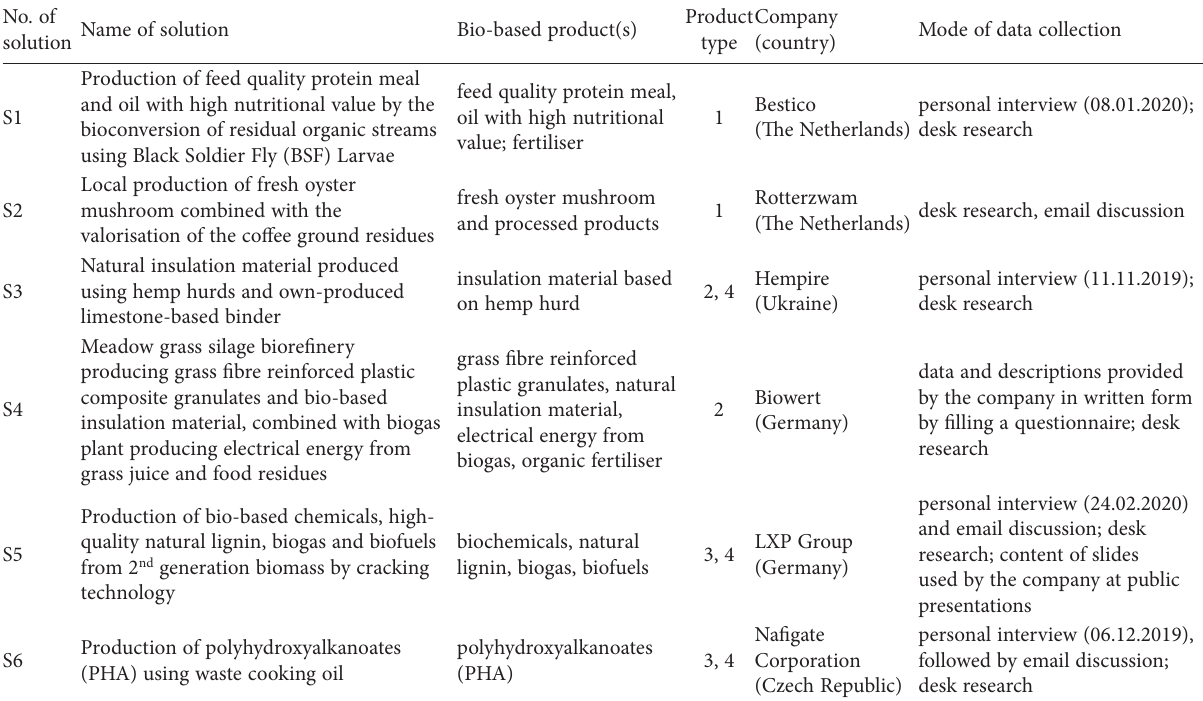
Table 1. Summary of the bio-based solutions selected for this study. Product types, defined in Section 2.1, are as follows: 1: Final product, 2: Material, 3: Building block or polymer, 4: Technology licensing. No.